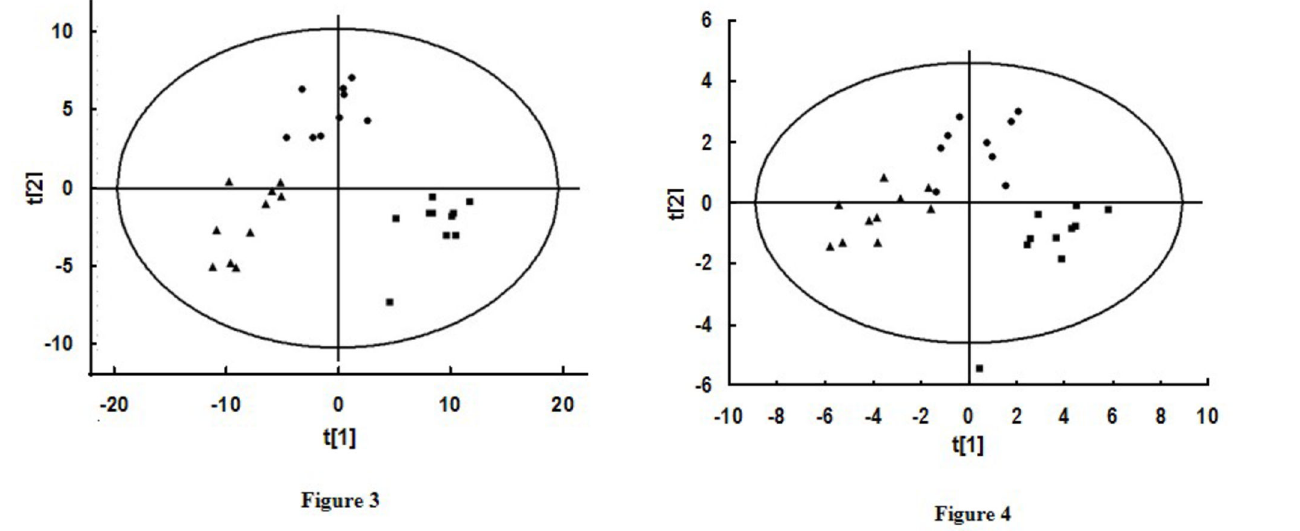
Figure 4. The score plot of PCA analysis with marker difference metabolites. Class 1 (■), Young group; Class 2 (●), Aged group; Class 3 (▲), Aged rTMS group. The PCA score plot showed the samples from different groups were scattered into three different regions (each sample represents a mouse, n=10 in young group; n=9 in aged group; n=10 in aged rTMS group). doi: